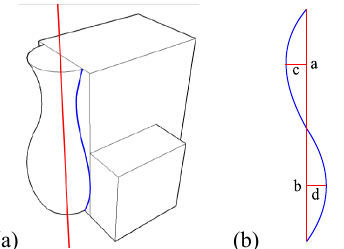
Figure 8. (a) Reconstructed SOR structure (b) fitted contour line.